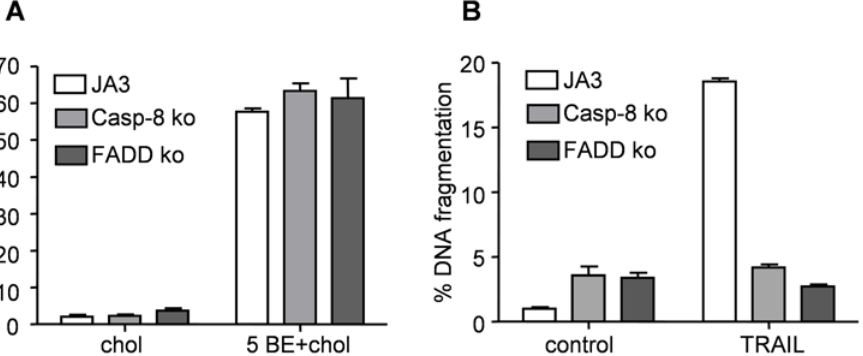
Figure 3. The death receptor pathway is not involved in BE/cholesterol induced apoptosis. Jurkat control (JA3), FADD deficient (FADD ko) or caspase-8 deficient (Casp-8 ko) cells were treated with TRAIL (0.5 m g/ml plus 1 m g/ml anti-FLAG) (A) or with either 5 m M cholesterol (chol) or 5 m g/ ml BE in combination with 5 m M cholesterol (5 BE + chol) and after 24 hours DNA fragmentation was analyzed.